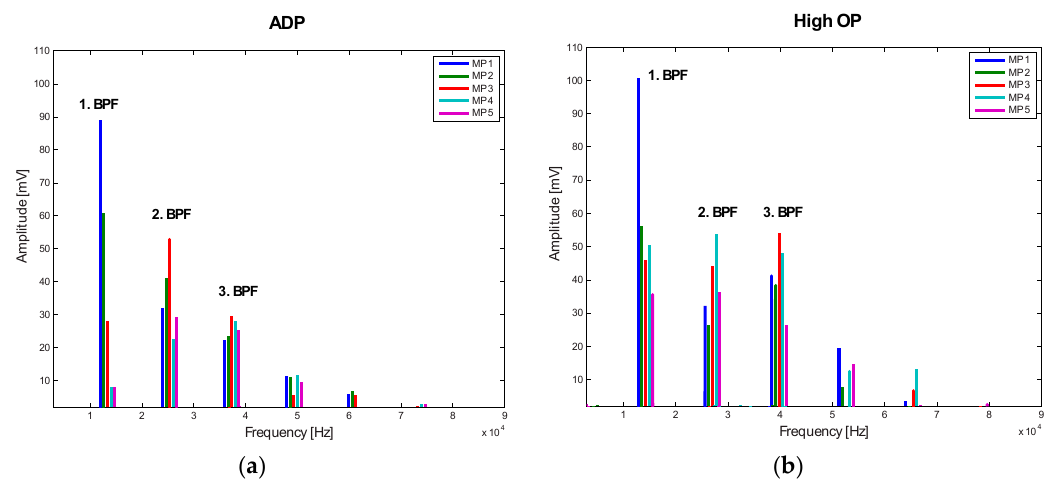
Figure 4. Frequency spectra of FRAPP raw signal at each radial measurement point for ( a ) ADP and ( b ) high OP. BPF: blade passing frequencies.